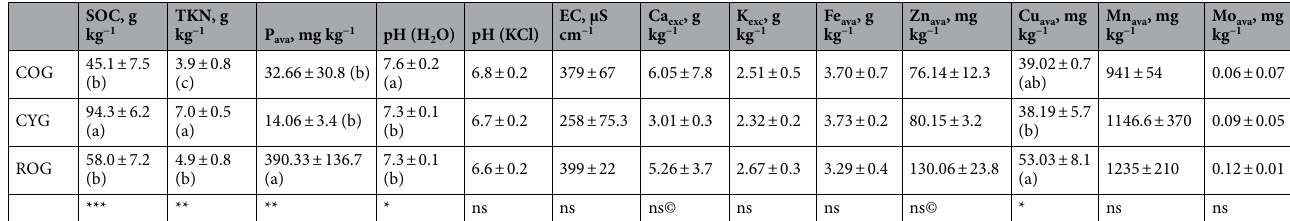
Table 1. Chemical properties (mean ± standard deviation of three replicates) of Lama Giulia soils. COG control soil, CYG cypress soil, ROG Robinia pseudoacacia L. Soil, SOC soil organic carbon, TKN total kjeldahl nitrogen, Ava available, EC electrical conductivity, Exc exchangeable. The values in each column followed by a different letter are significantly different according to HSD test or Friedman test ©. *Significant at p ≤ 0.05; **significant at p ≤ 0.01; ***significant at p ≤ 0.001, ns not